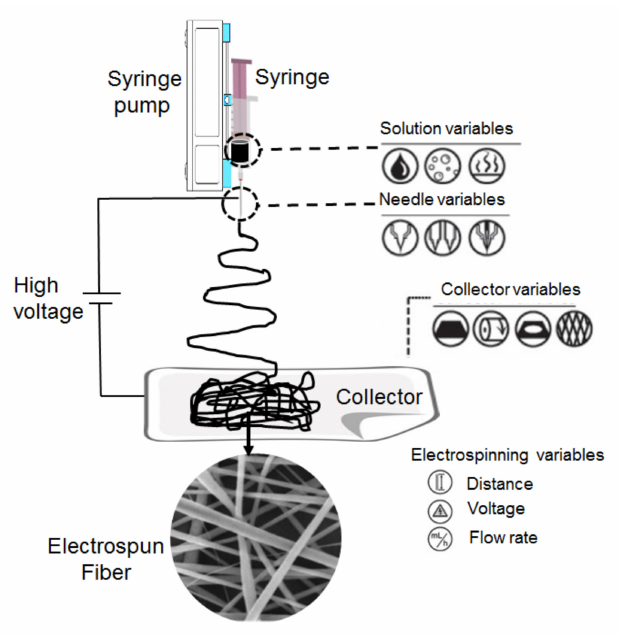
Figure 2. Schematic representation of a vertical electrospinning